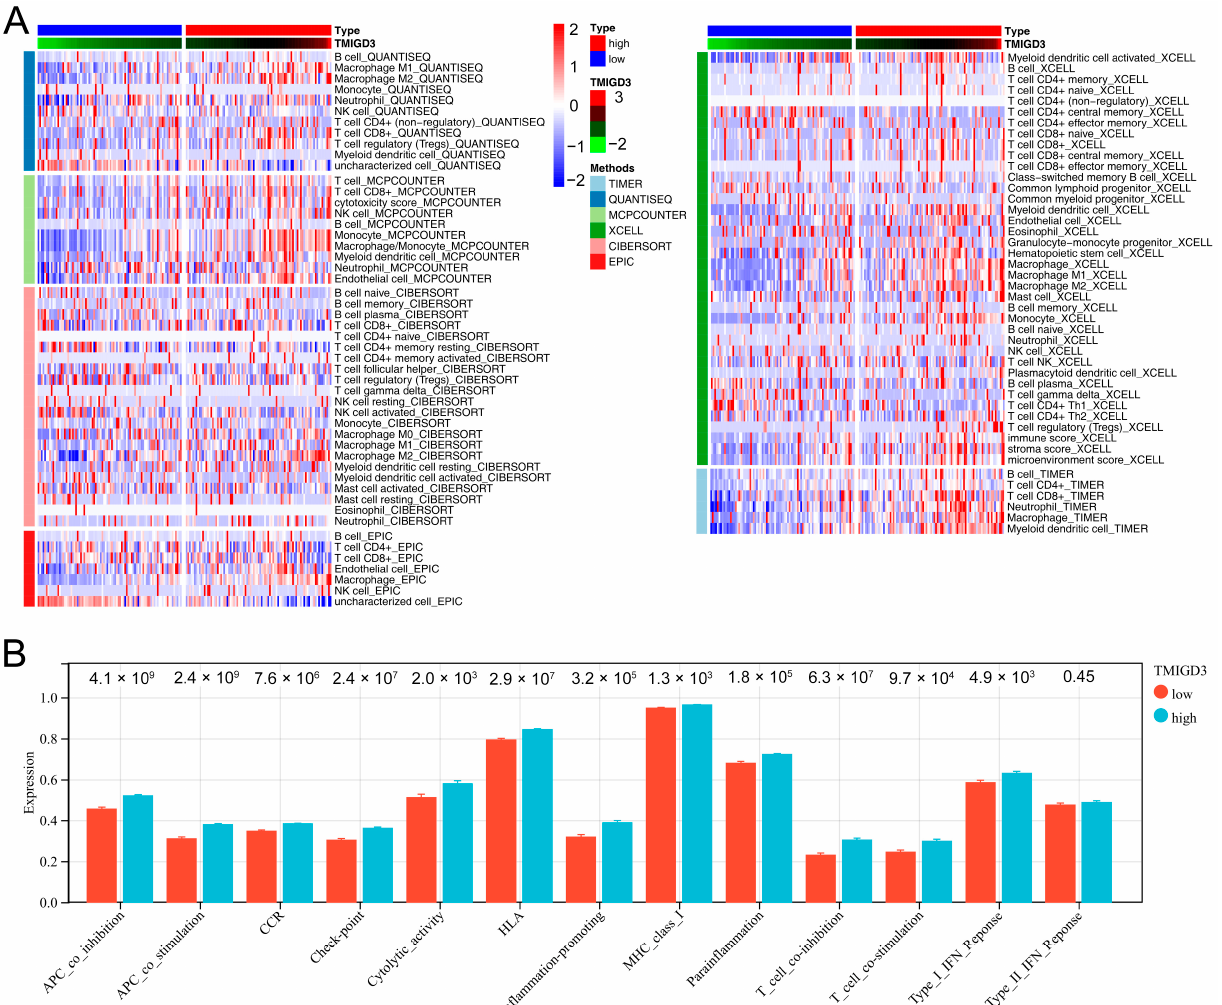
Figure 7. Effect of TMIGD3 on the tumor microenvironment. Notes: ( A ) Effect of TMIGD3 on Figure 7. E ff ect of TMIGD3 on the tumor microenvironment. Notes: ( A ) E ff ect of TMIGD3 on the the cells in tumor microenvironment quantified by multiple algorithms; ( B ) Effect of TMIGD3 on cells in tumor microenvironment quanti fi ed by multiple algorithms; ( B ) E ff ect of TMIGD3 on immune immune function.